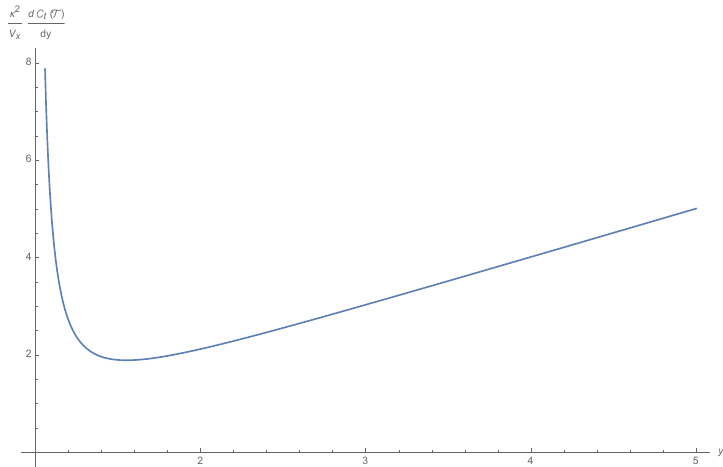
Figure 3. Time derivative of the HPIC as a function of y = | t 0 | /(cid:15) for T = 0 in d = 3